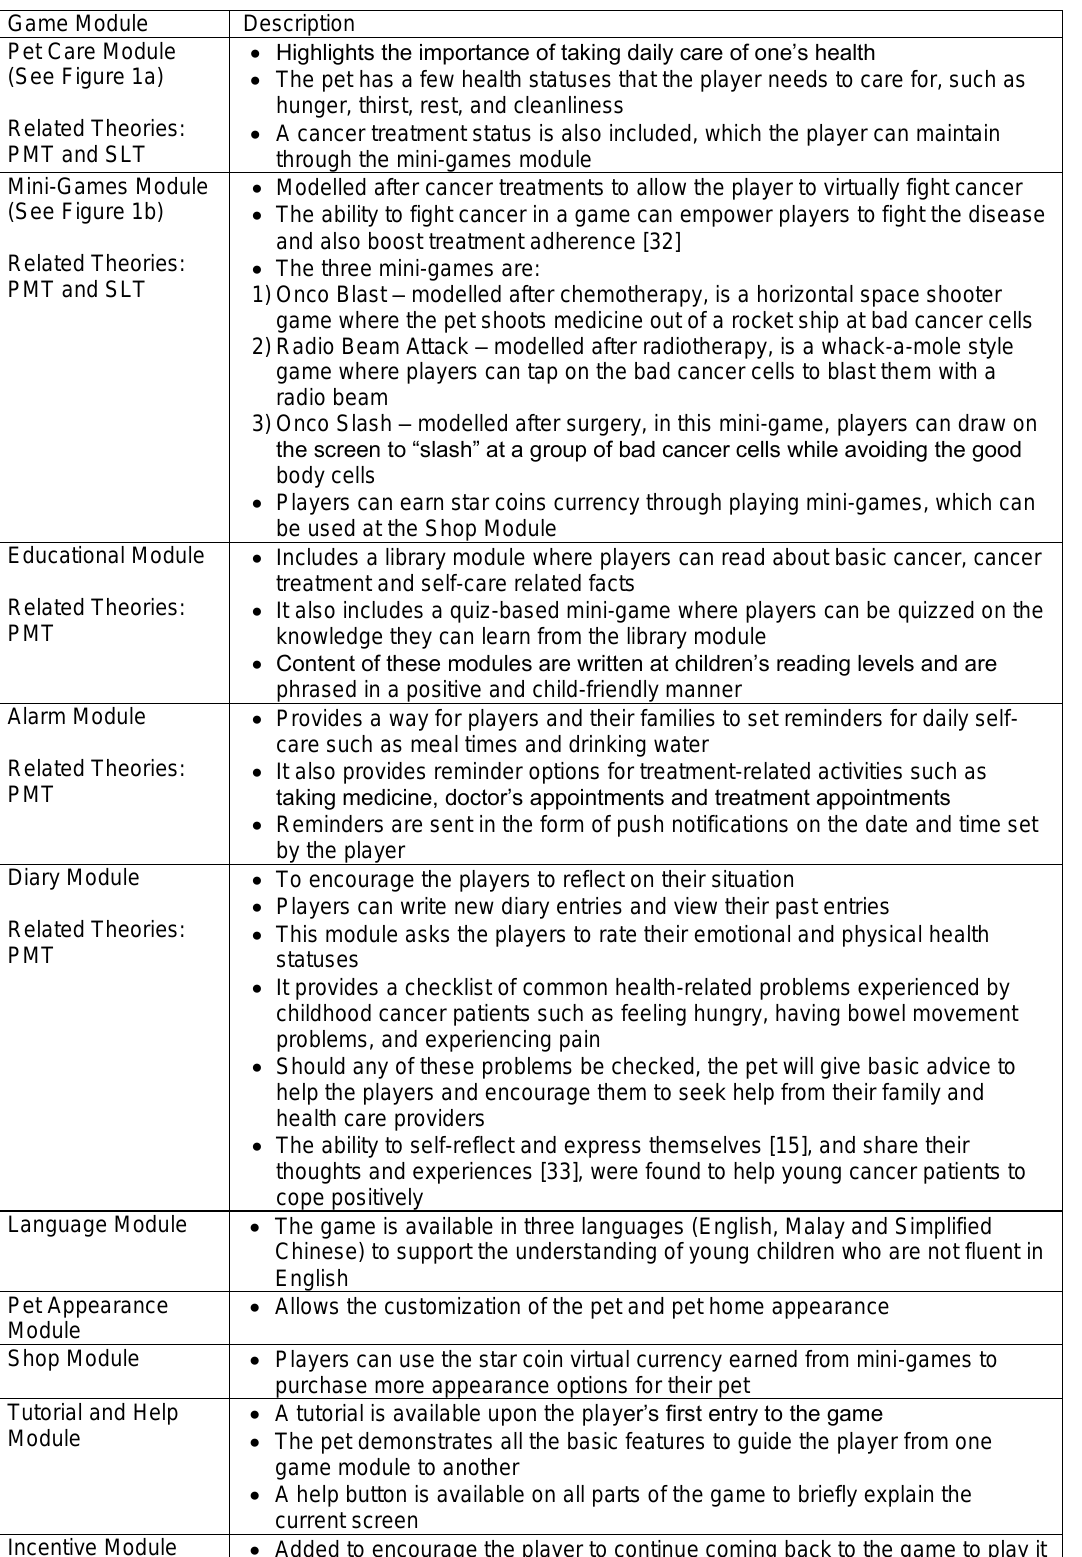
Table 1. Key Game Modules of Pets vs